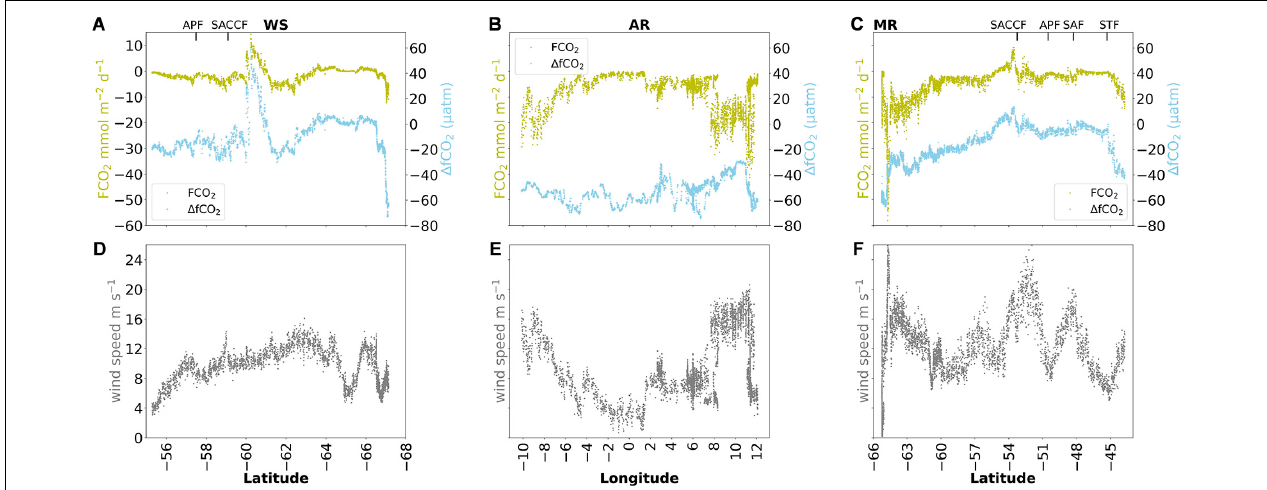
FIGURE 4 | Spatial distributions of CO 2 flux (FCO 2 , mmol m − 2 d − 1 ) with the sea-air gradient of fCO 2 ( (cid:49) fCO 2 , µ atm) and wind speed (m s − 1 ). Column 1: (A,D) WS region, Column 2: (B,E) AR region, and Column 3: (C,F) MR region.